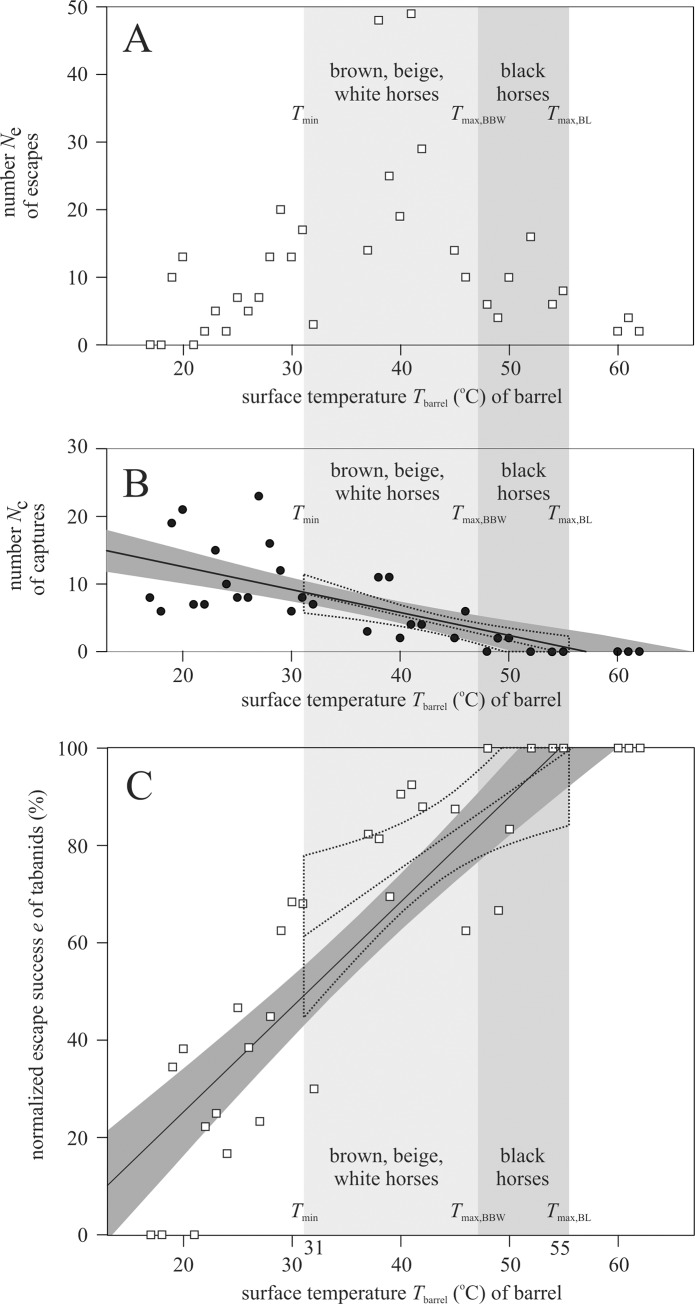
Escape success of horseflies versus surface temperature.Number Ne of escaped (A) and number Nc of captured (B) tabanids that landed on barrels as a function of the surface temperature Tbarrel (oC). In B a continuous straight line indicates the linear fit to all Nc(Tbarrel) data (black circles in the interval 17°C ≤ T ≤ 62°C), and a dark grey band around this fit shows the 95% confidence interval. (C) Normalized escape success e = Ne/(Ne + Nc) versus Tbarrel (oC). A continuous straight line and a dark grey band illustrate the linear fit to all e(Tbarrel) data (white squares in the interval 17°C ≤ T ≤ 62°C) with 95% confidence interval. The vertical light and medium grey columns denote the interval Tmin = 31°C ≤ T ≤ Tmax,BBW = 47°C of the surface temperature of brown, beige and white horses (BBW) and the interval Tmin = 31°C ≤ T ≤ Tmax,BL = 55°C of black (BL) horses measured by thermography (Fig 2). In B and C a dotted straight line and a 95% confidence interval with dotted perimeter illustrate the linear fit to the data within the 31°C ≤ T ≤ 55°C interval.